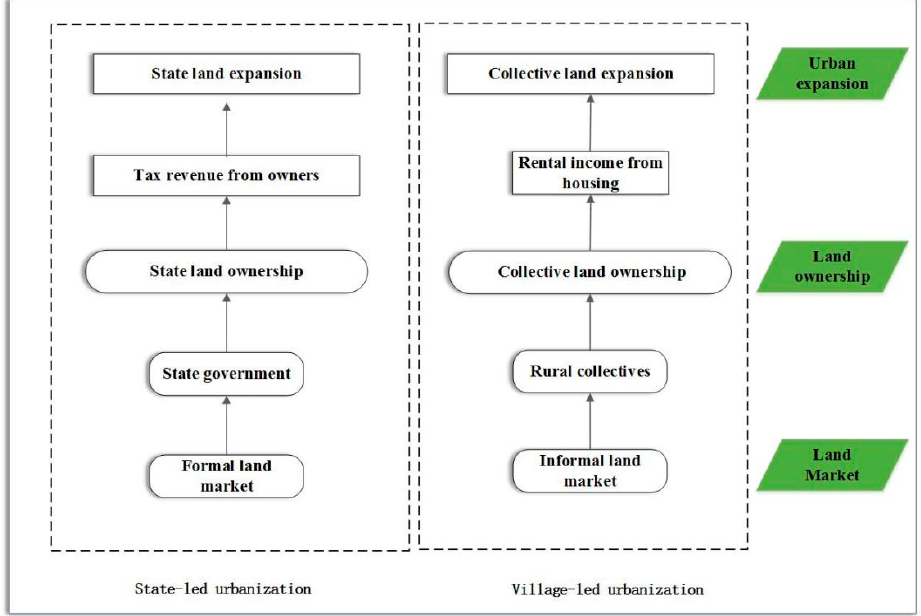
Figure 1. Research framework. (Source: drawn by the authors).